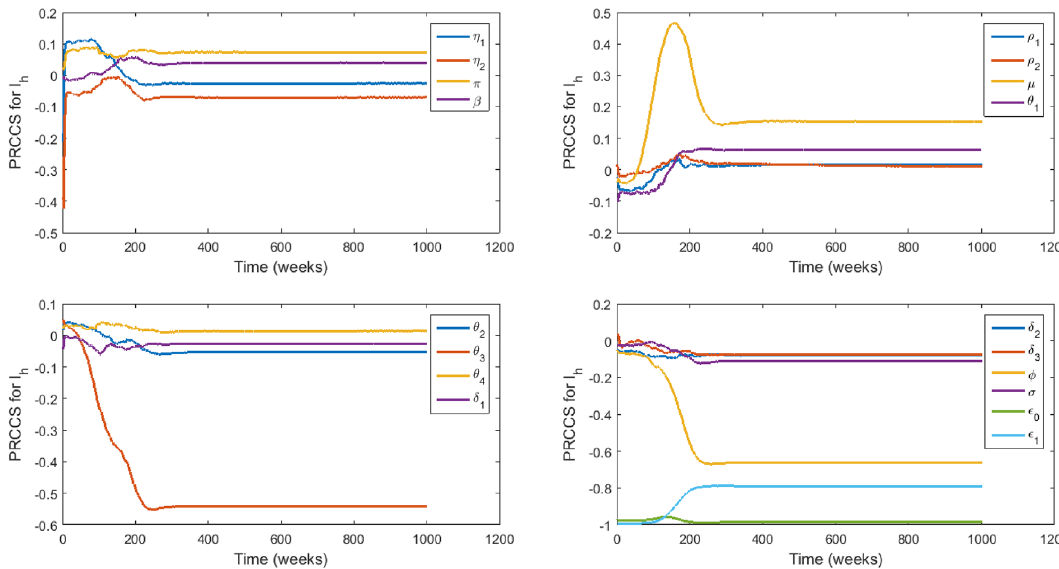
Figure 4. PRCC values of model (2)–(10) with I h as the response function.